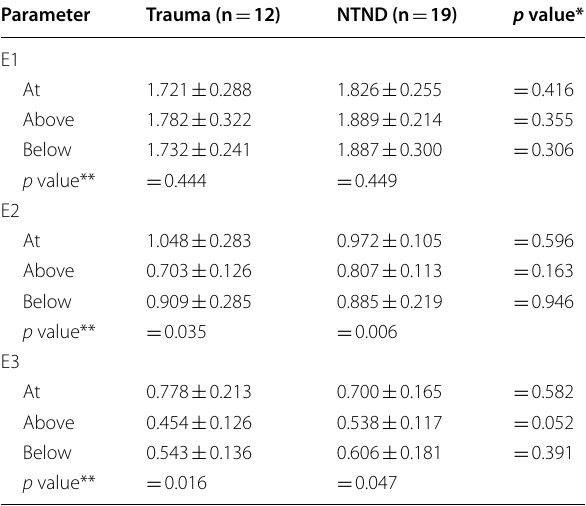
Table 1 Repeated‑measures ANOVA test comparing the difference in the calculated mean of different DTI metrics within the same group of pathology and between different pathology along the study cohort